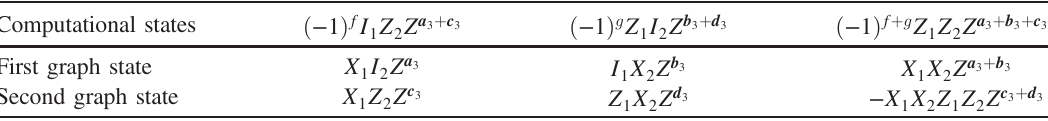
TABLE II. Mermin-Peres magic